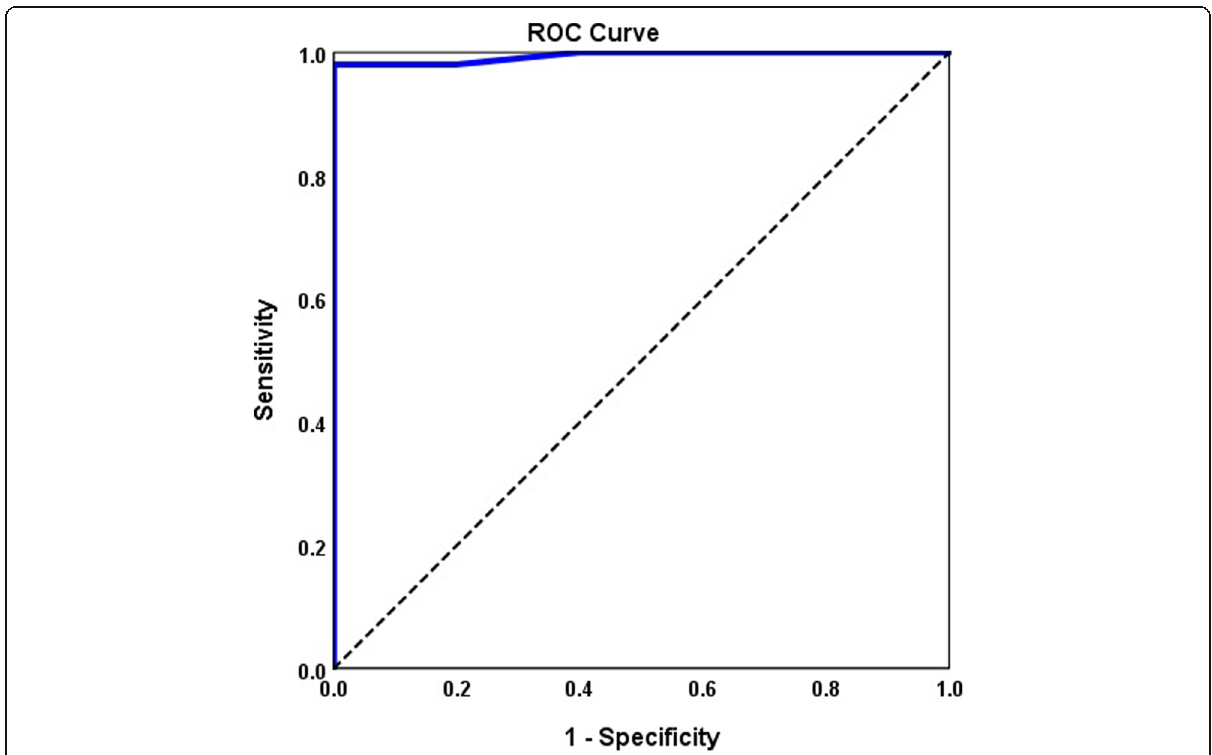
Fig. 6 ROC curve analysis to explore the discriminant ability of mean ADC value to differentiate (grade II and III) from (grades I)